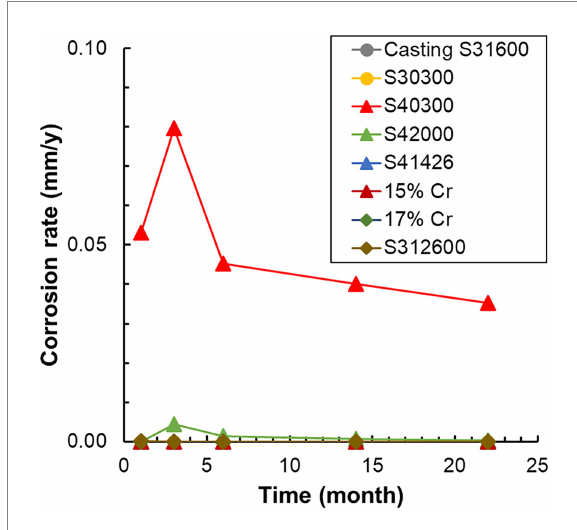
FIGURE 2 Variation in the corrosion rate of each metal with time. The corrosion rates are calculated using weight loss and immersion time. S1, Casting S31600; S3, S30300; S4, S40300; L8, S42000; HP, S41426; 5C, 15% Cr; 7C, 17% Cr; and J, S31260.